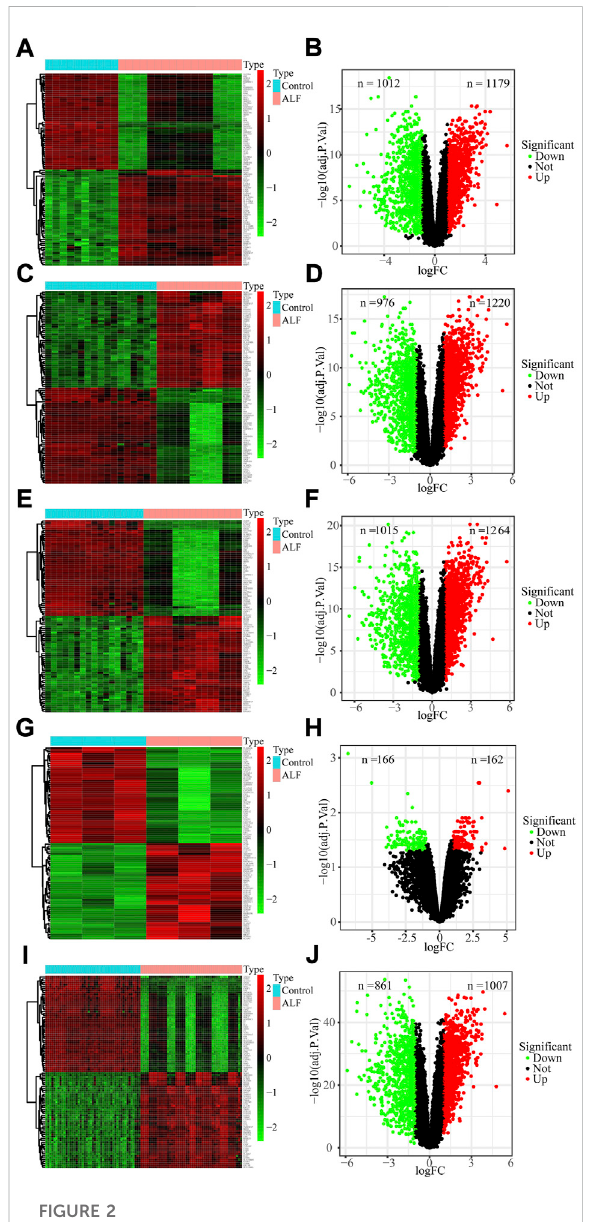
FIGURE 2 Identi fi cation of DEGs from GEO datasets. (A,B) GSE38941, (C,D) GSE62029, (E,F) GSE96851, (G,H) GSE120652 and (I,J) merged